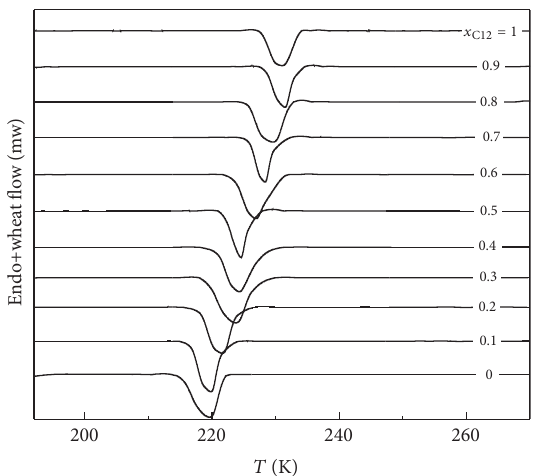
F 6: DSC curves of C (7.8nm) as a function of mole fractions of C